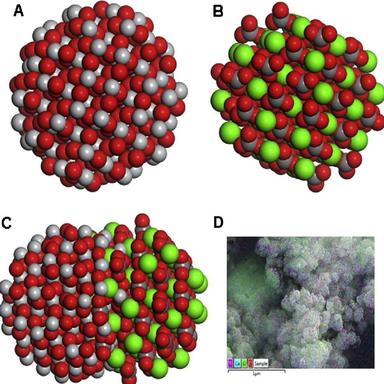
(A) molecular structure for titanium dioxide; (B) molecular structure of calcite (C) structural interaction of calcite-titanium dioxide; (D) EDX mapping of TiO2-EB.